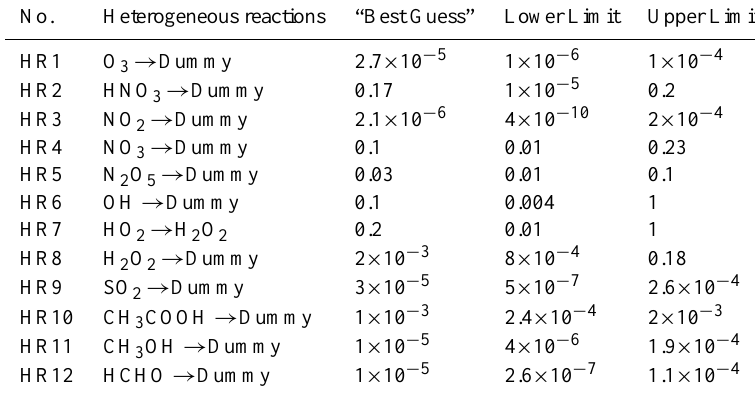
Table 1. Heterogeneous removal reactions and reactive uptake